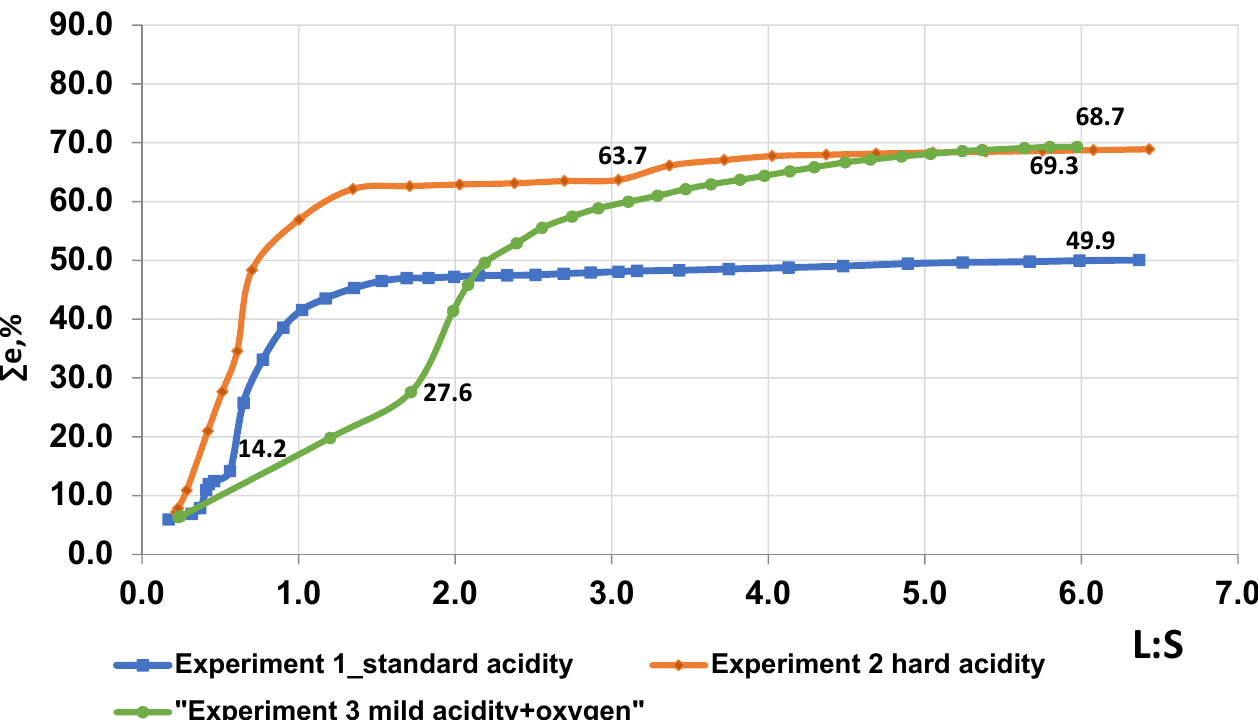
Figure 4. Uranium extraction depending on L:S.